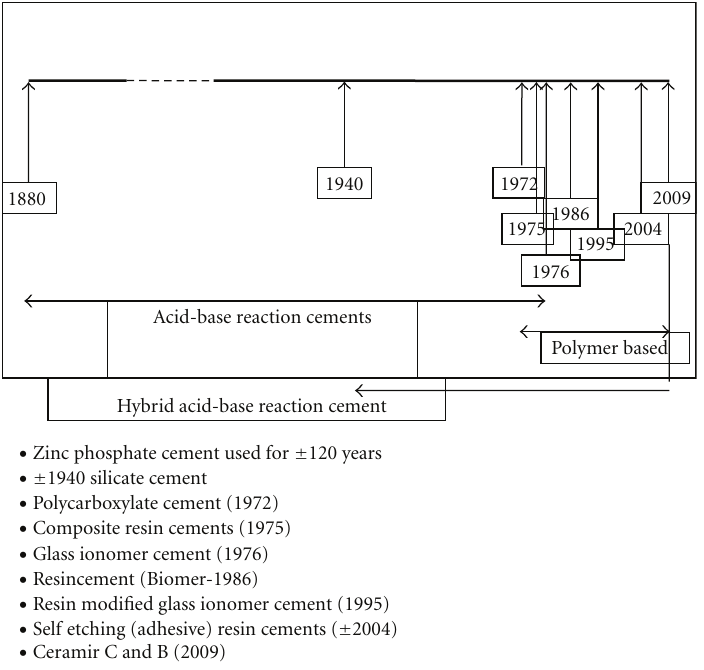
Figure 1: An overview of the chronological development of luting agents starting around 1880 until today. The last 30–40 years have witnessed the development of new cement systems and a large number of cements have become available. It was not until 2009 that a paradigm shift took place and a hybrid acid-base reaction cement was introduced, which o ff ered physical and other properties that not only di ff ered from the polymer-based luting agents but also matched them. +1880—zinc phosphate cement, +1940—silicate cement ∗ , 1972— polycarboxylate cement, +1975—composite resin cements, 1976—glass ionomer cement, 1986—resin cement, +1995—resin-modified glass ionomer cement, +2004—self-etching (adhesive) resin cements, 2009—hybrid-acid-base reaction cement, ( ∗ the designation silicate cement is a misnomer as it was a restorative material for Cl III and Cl V